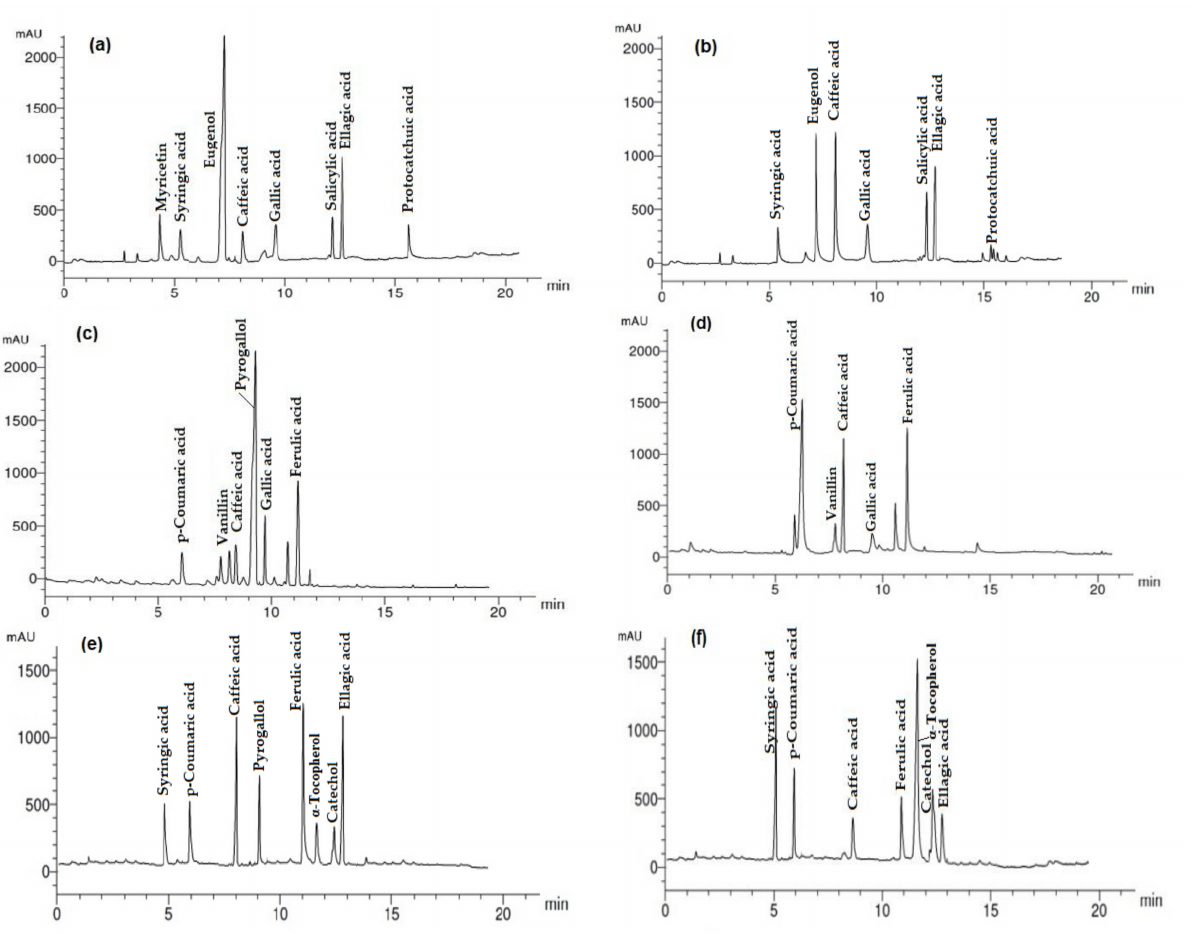
Figure 2. HPLC chromatograms of polyphenolic compounds detected in the methanol extracts of strawberry fruits from ( a ) the original fruit sample; ( b ) untreated fruits; and treated fruits with ( c ) E. camaldulensis var obtusa EO; ( d ) M. piperita EO; ( e ) E. camaldulensis var obtusa and M. piperita mix EOs (1/1 v / v ) and ( f ) M. oleifera FO. Table 4. HPLC analysis of polyphenolic compounds in strawberry fruits treated with natural oils after 18 from the storage